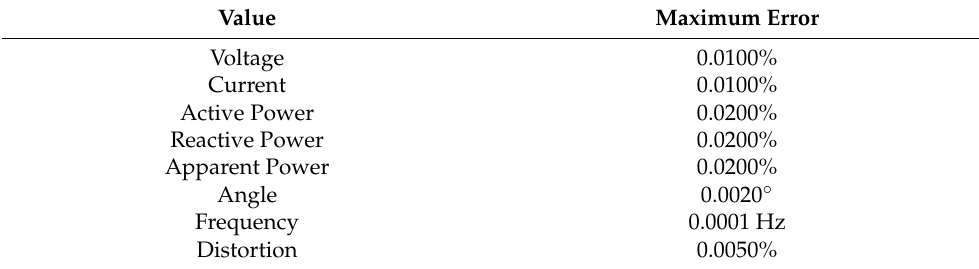
Table 3. Maximum errors of measured values.